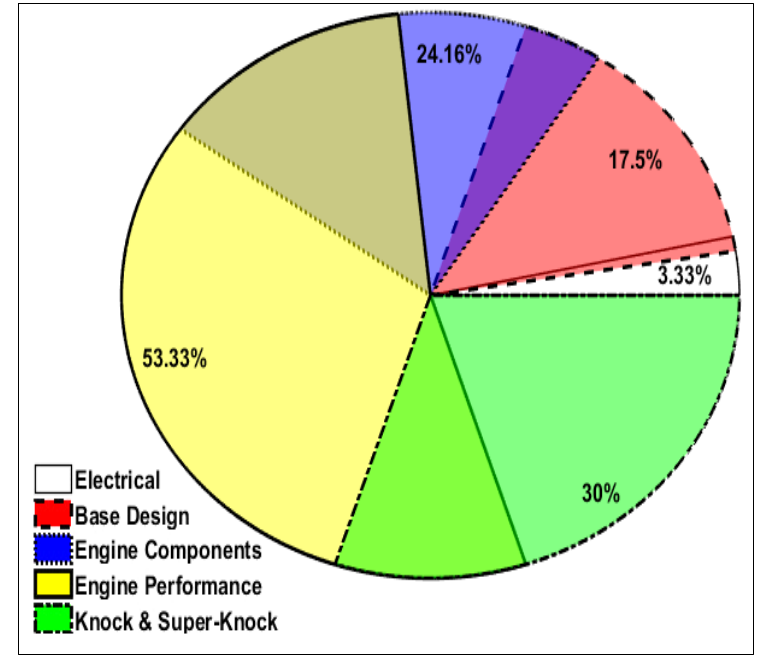
Figure 4. The overlaps and proportion of each field in engine downsizing published